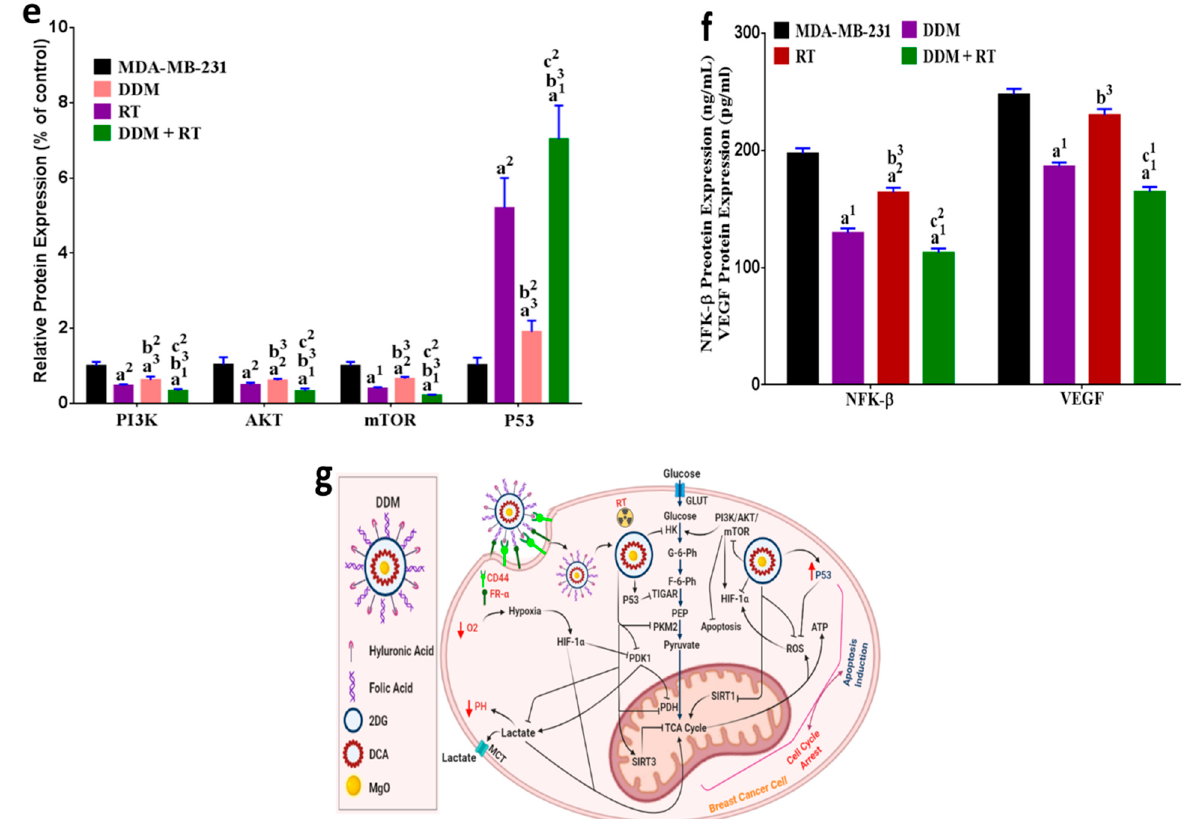
Figure 7. DDM and/or RT modulate key proteins involved in the regulation of glycolysis and OXPHOS pathways in BC cells. PI3K, AKT, mTOR, P53, and β -actin protein levels in MCF-7 cells ( a , b ) and MDA-MB-231 cells ( d , e ). NF- κ B and VEGF levels (ELISA) in both cell groups ( c , f ). ( g ) Schematic representing the mode of action of targeted multifunctional core–shell-nano (DDM) and RT. The DDM core–shell is a chemotherapy drug targeted to cancer cell surfaces via cancer cell-specific ligands. DDM binds to surfaces by recognizing specific receptors resulting in DDM internalization via endocytosis. Inside the cell, DDM undergoes endosomal escape leading to cytotoxic drug release. Treatment with DDM alone or as a radio-sensitizer (prior to RT) induces cancer cell death through modulating the metabolic reprogramming displayed by BC cells via a novel PI3K/AKT/mTOR/P53/NF- κ B/VEGF pathway. ( → ) Indicates pathway direction and (T) indicates blocking functions. All group values are presented as the mean ± standard error of the mean (SEM). a1 p < 0.001, a2 p < 0.01, a3 p < 0.05 vs. control; b1 p < 0.001, b2 p < 0.01, b3 p < 0.05 vs. DDM group; c1 p < 0.001, c2 p < 0.01, c3 p < 0.05 vs. RT group.